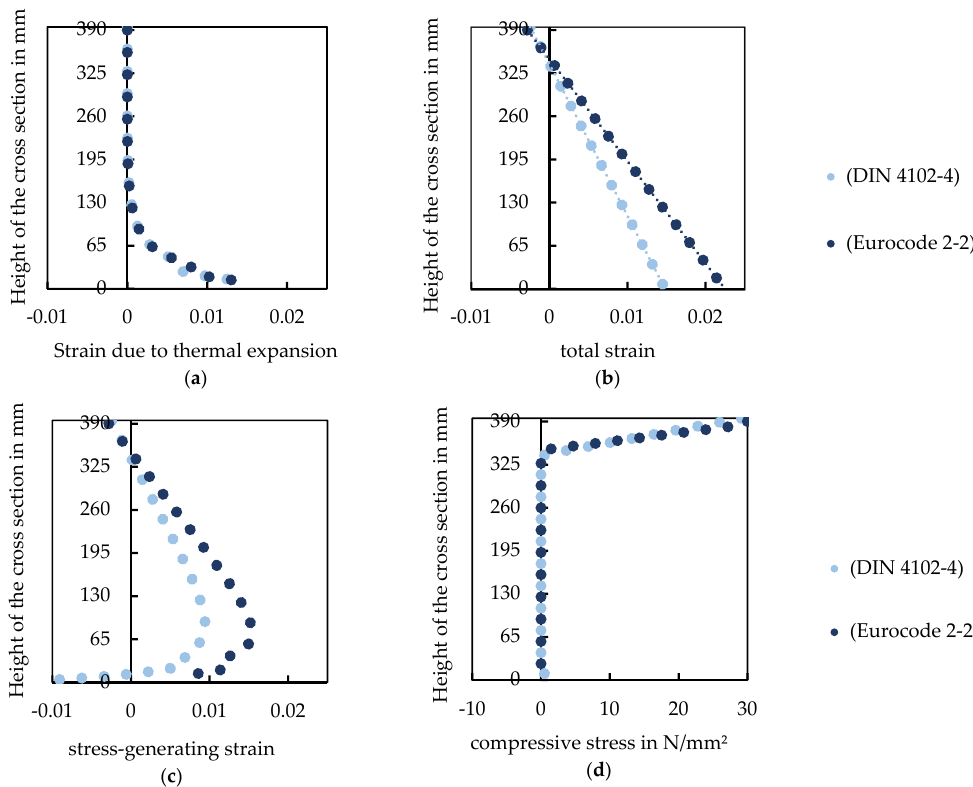
Figure 12. ( a ) Strain due to thermal expansion, ( b ) Total strain, ( c ) Stress-generating strain, and ( d ) Compressive stress of the solid slab after 90 min fire exposure with dimensions based on [5,6].